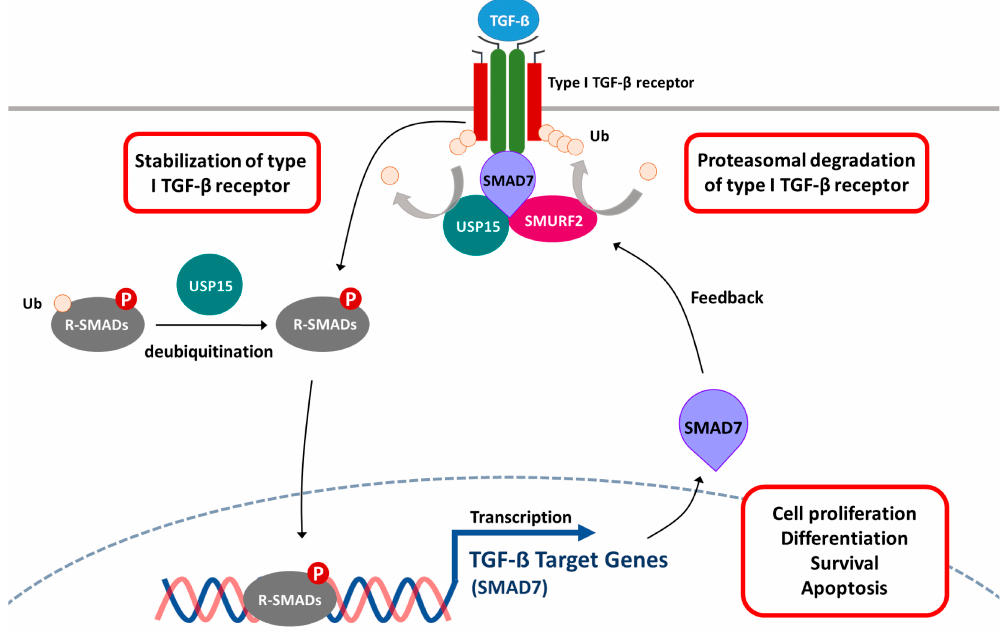
Figure 3. USP15 acts as a “biological thermostat” in the TGF- β signaling pathway. USP15 competes with the action of SMAD7-SMURF2 complex that trends to promote the ubiquitination of type-1 TGF- β receptor. USP15 participates in deubiquitination of the monomeric ubiquitin from R-SMADs, which participates in transcription of TGF- β target genes. Protein ubiquitination is indicated by the presence of an attached ubiquitin moiety (Ub). The phosphate group (P) is shown as a red sphere.